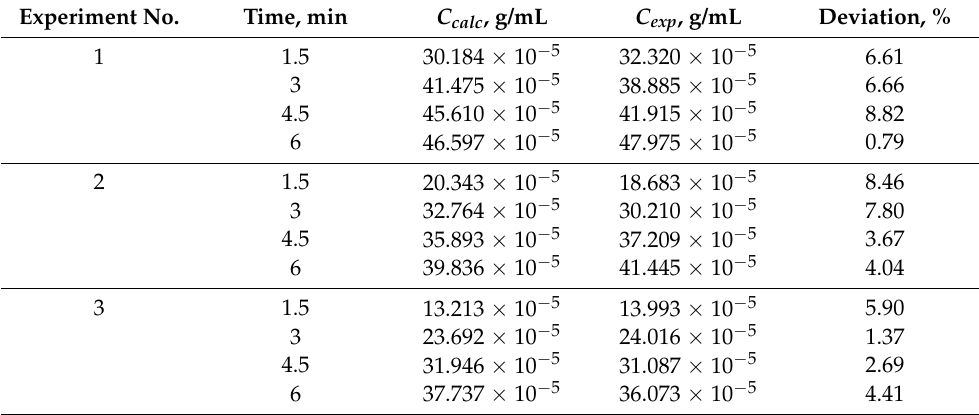
Table 2. Calculated and experimental values of released melatonin. Experiment